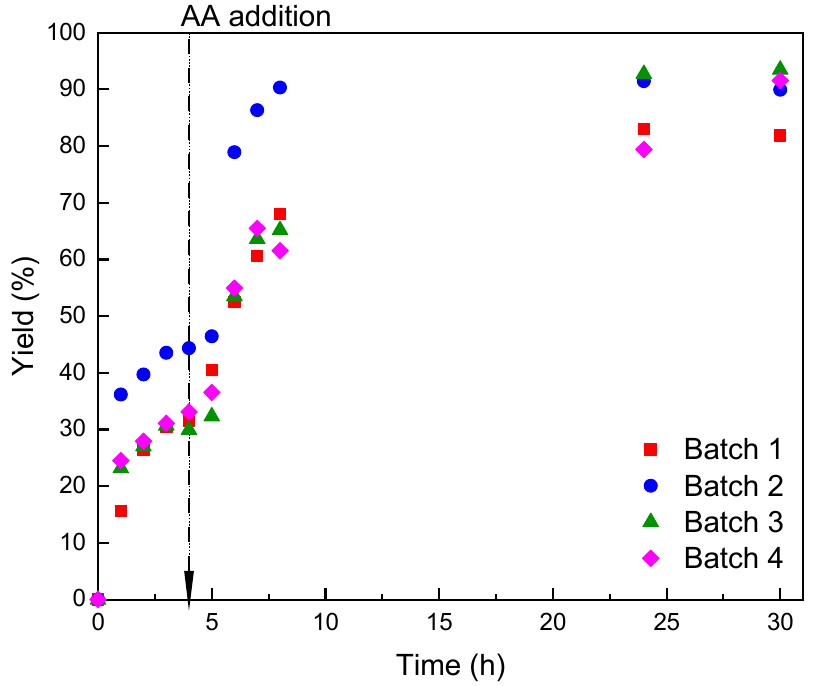
Figure 5. Synthesis of ascorbyl palmitate in a rotating bed reactor operated in sequential batches using lipase Lipozyme ® 435. Reaction conditions: substrates ratio 1:8, 55 °C, 290 rpm, 1.8 g molecular sieve in 2-methyl-2-butanol.